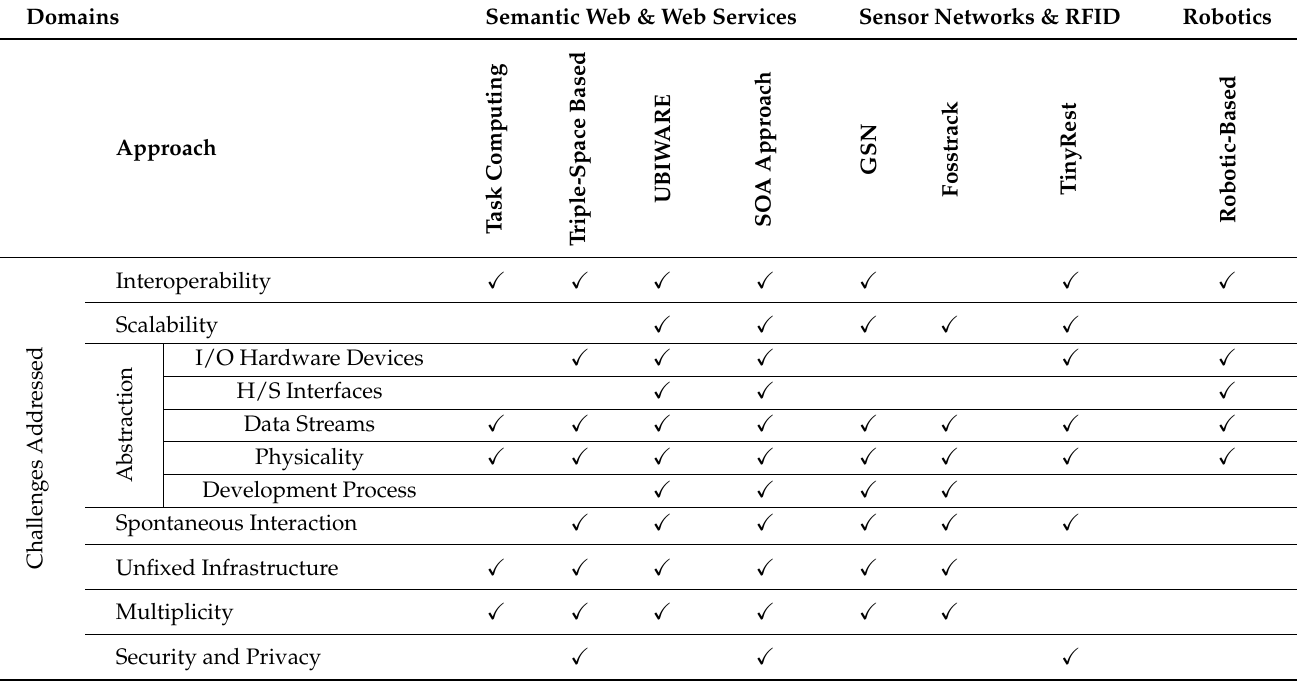
Table 8. Challenges in middleware approaches for IoT